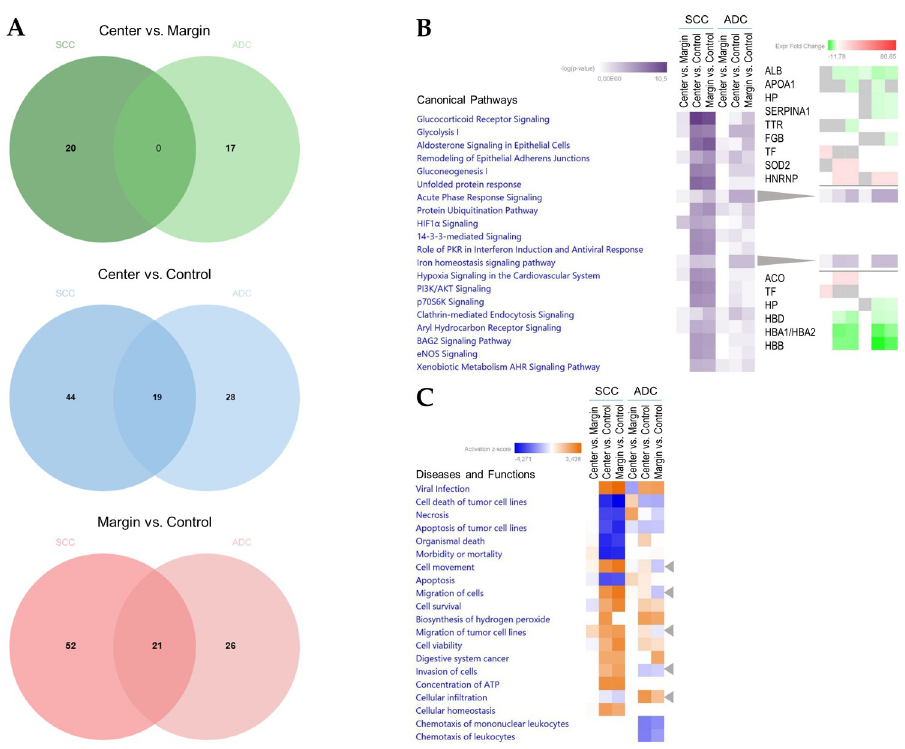
Fig 8. Venn diagrams and IPA comparison analysis for proteins in each NSCLC subtype, ADC and SCC. (A) Venn diagrams comparing proteins identified in SCC or ADC for the following comparisons: center vs. margin, center vs. control, and margin vs. control. (B) The heat map of the top 20 Canonical Pathways (left panel) across different comparisons displaying the Fisher’s exact test p-value (expressed as–log[p-value]). Proteins positively or negatively correlated with Acute phase response signaling or Iron homeostasis signaling are shown as a protein expression fold change heat maps (right panel). (C) The heat map displays the z-scores (abs(z) � 2 in at least on comparison) from top 20 Diseases and Functions analysis (orange and blue rectangles represent activation and suppression,